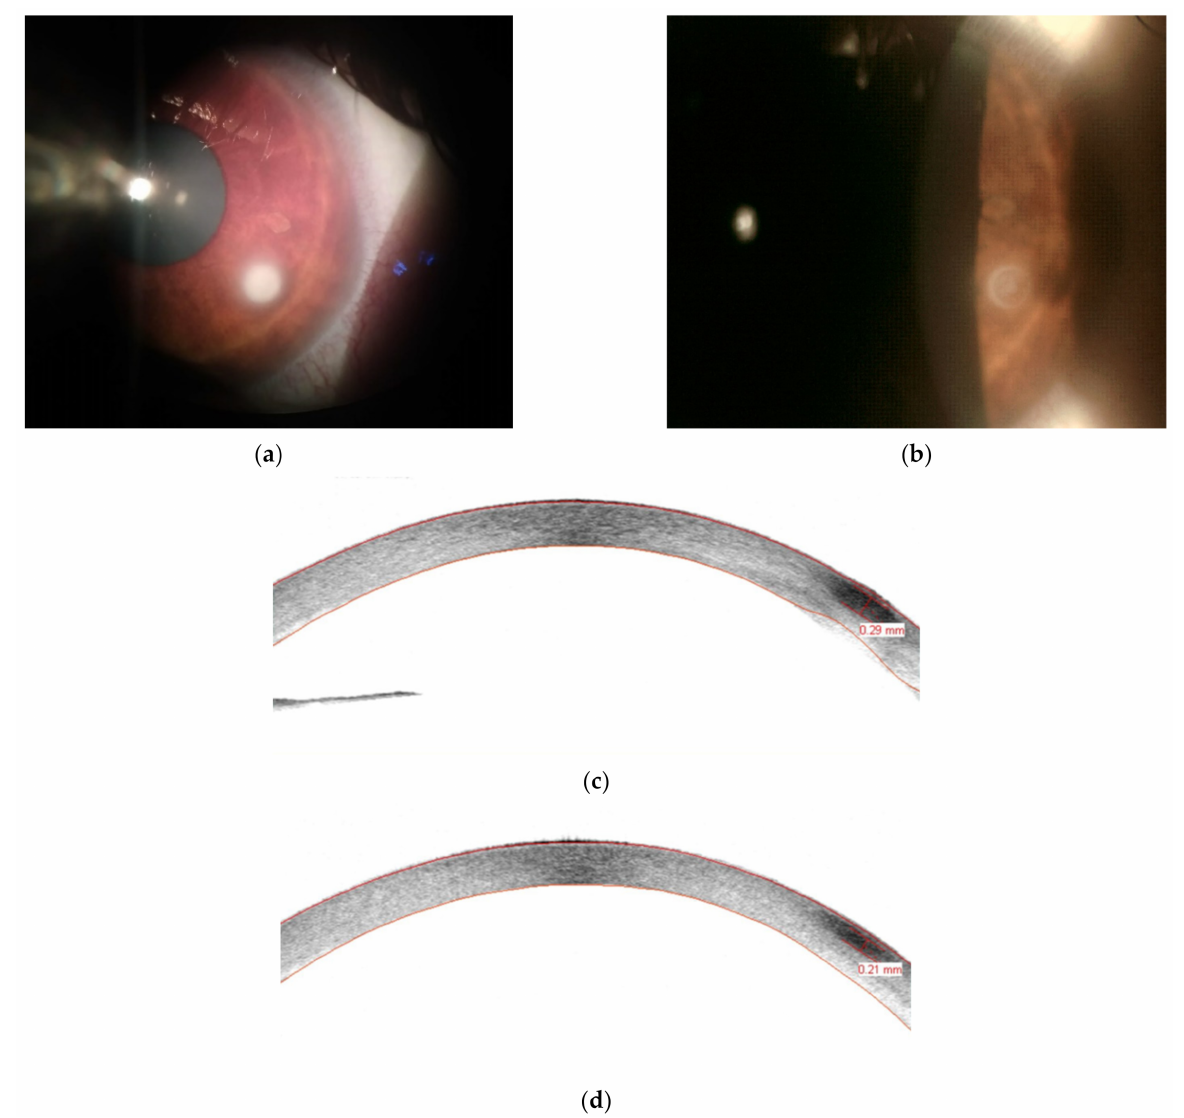
Figure 2. Successful treatment of the small, initial F. oxysporum SC infiltrate in a 46-year old contact lens user. ( a ) Opaque, white infiltrate with a cloudy margin in the lower temporal corneal quadrant observed on the fifth day after the first onset of symptoms. Diagnosis was based on the presence of fungal hyphae in confocal microscopy and corneal impression cytology stained with periodic acid–Schiff and hematoxylin–eosin. ( b ) Opacity reduction and sharpening of the infiltrate edges with resolution of the irritation observed on the sixteenth day of treatment with topical 1% voriconazole. AS-OCT scans performed on the second ( c ) and twelfth ( d ) days of treatment. Best-corrected visual acuity remained 20/20 during the entire eight week-long course of illness and